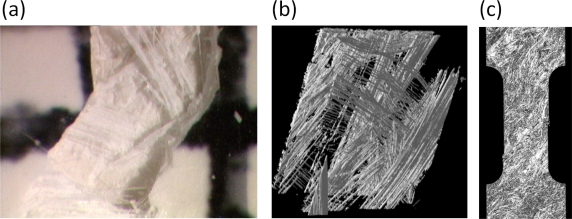
(a) Light microscopic view of a glass fiber reinforced sheet moulding compound (SMC) which is used in car industry as light-weight material. (b) CT-microscopic reconstruction of a section of the laminar glass fiber structure in the material. (c) Scanning Acoustic microscopic view of a tensile-test SMC specimen exhibiting the glass fiber bundles within the compound. Figure by M.O. Steinhauser, Fraunhofer EMI.